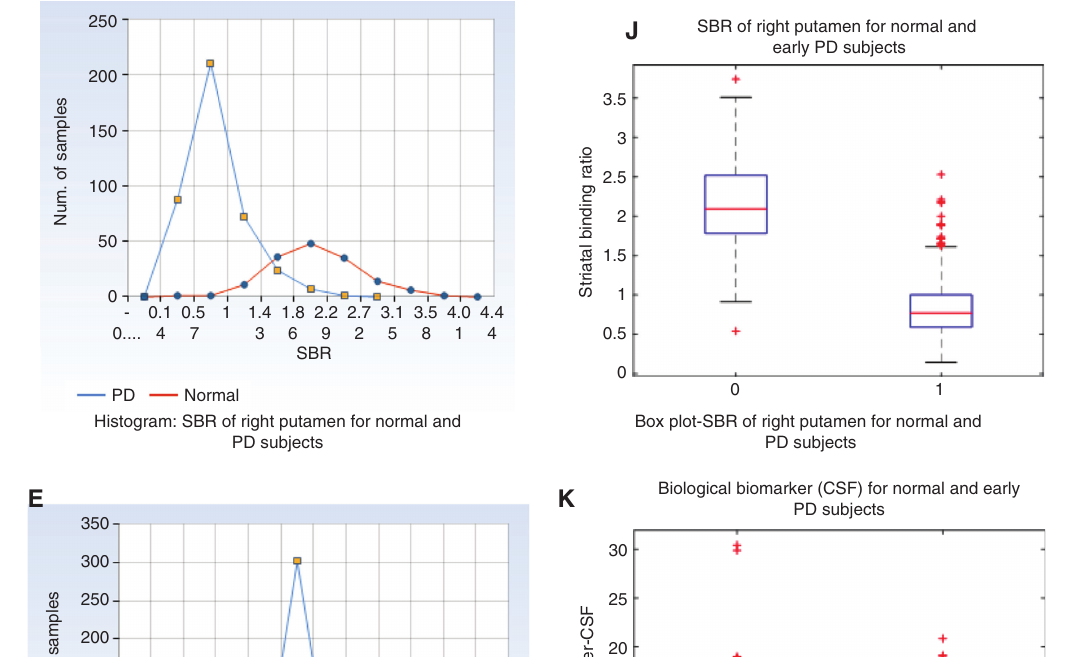
biomarker (CSF) for normal and early PD subjects